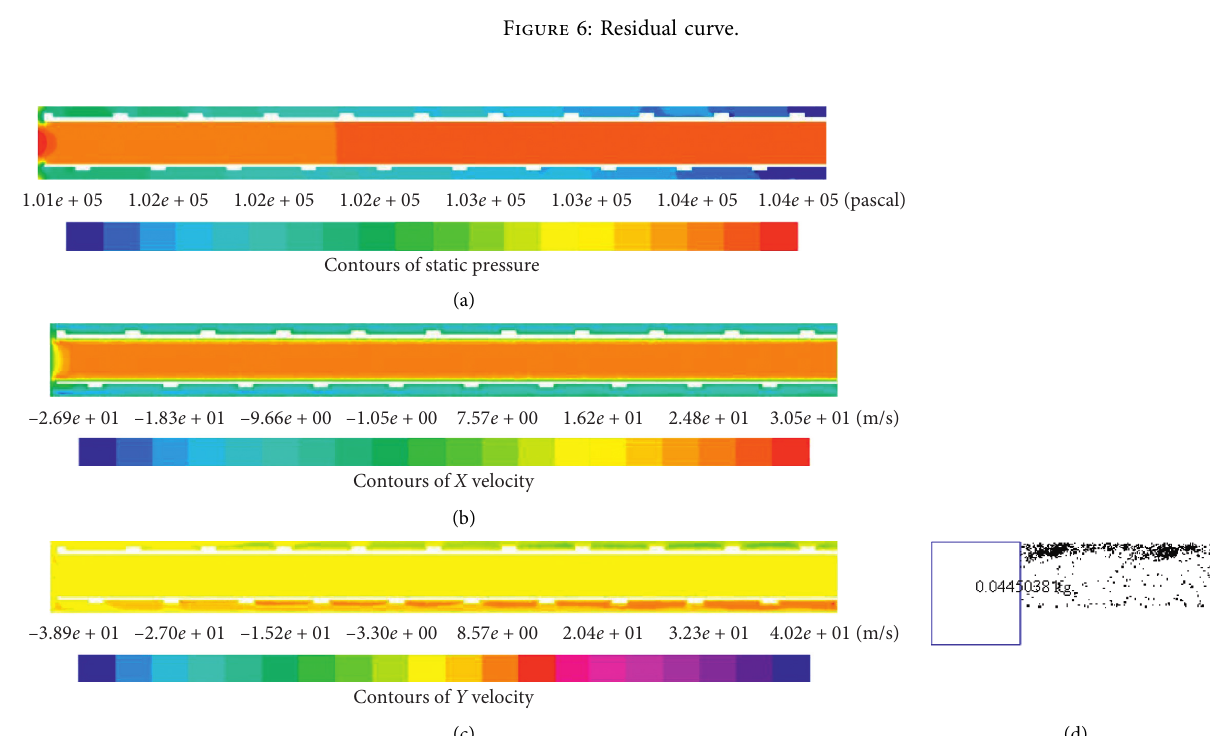
Figure 6: Residual curve.